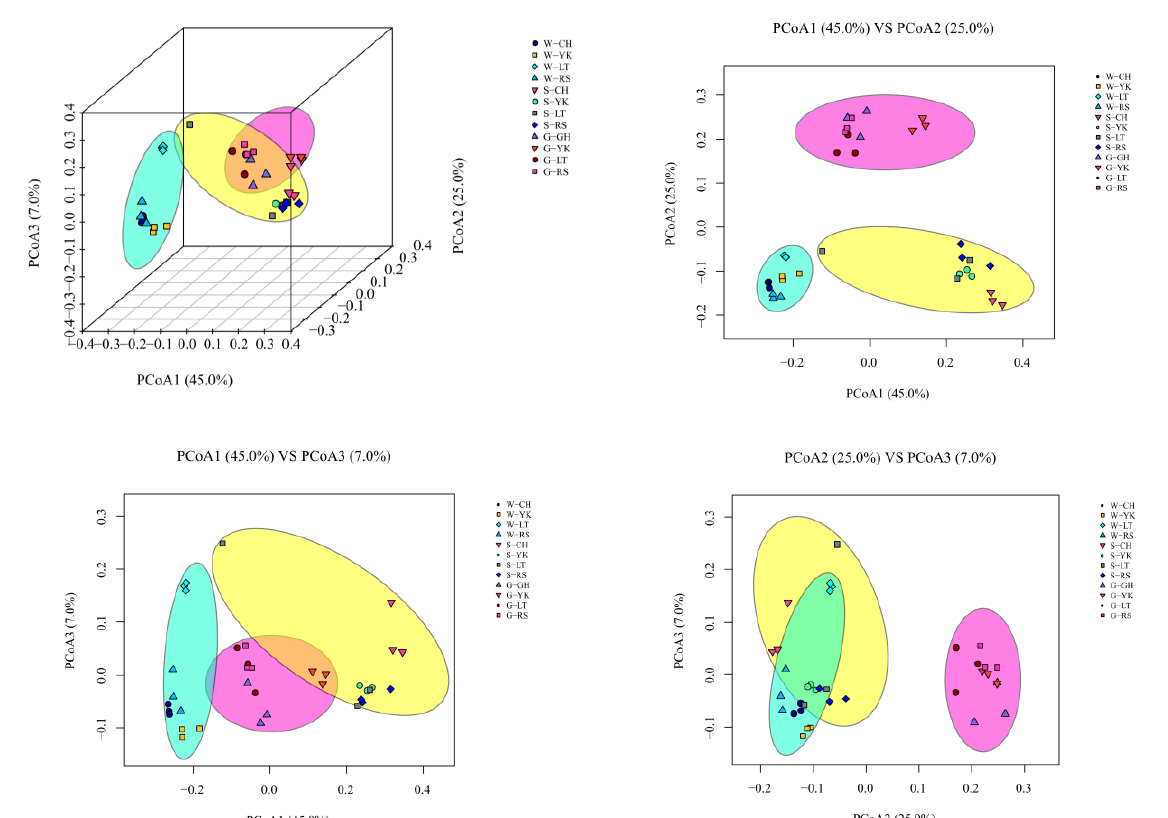
Figure 3. Beta-diversity analyses of the bacterial communities of water (W), sediments (S), and the gut of Apostichopus japonicus (G) in different areas. Three-dimensional principal coordinate analysis (PCoA) of bacterial communities in different samples based on OTU-level weighted Unifrac distances.